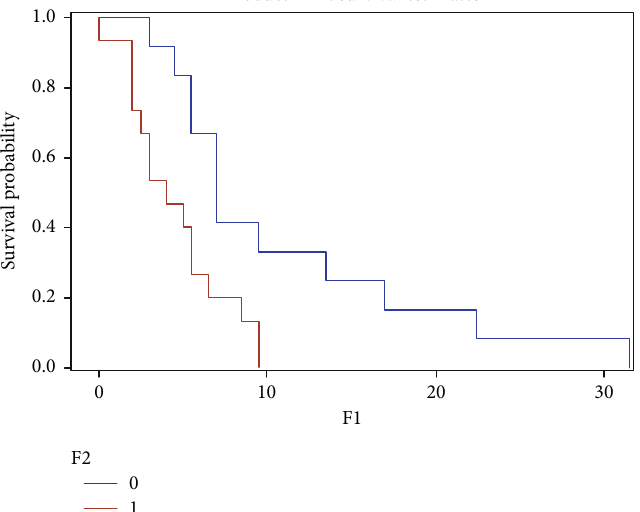
Figure 3: Kaplan-Meier survival curves of grade IV gliomas — GBM. The graphs shows a shorter survival in patients with TREM-1/TREM-2 ratio > 125 ( P = 0 : 007 ). Test used: Log Rank; x -axis: survival time in months; y -axis: survival probability; 0: patients with TREM-1/TREM-2 ratio < 125 ( n = 12 ); 1: patients with TREM-1/TREM-2 ratio > 125 ( n = 15 ); GBM: glioblastoma multiforme — grade